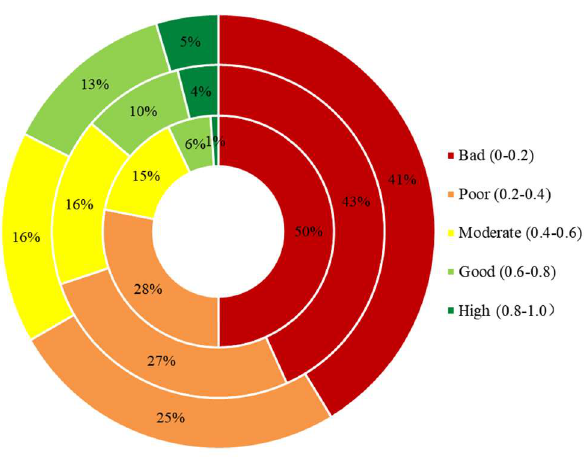
Figure 2 . The proportion of each ecological grade area (From outside to inside are 2020, 2010, 2000).